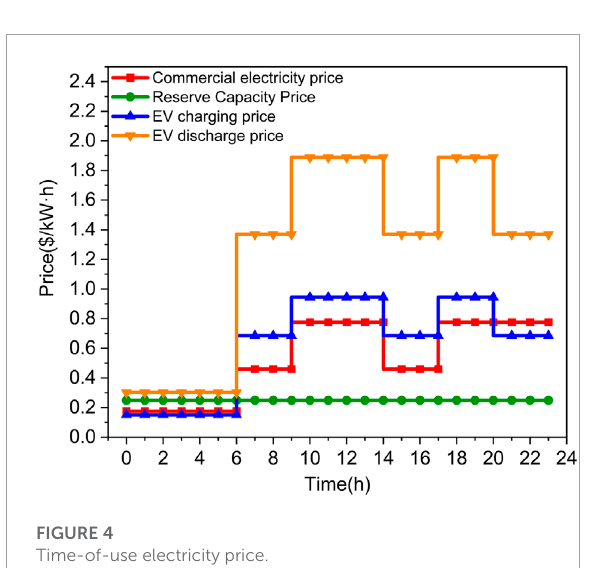
FIGURE 4 Time-of-use electricity price.